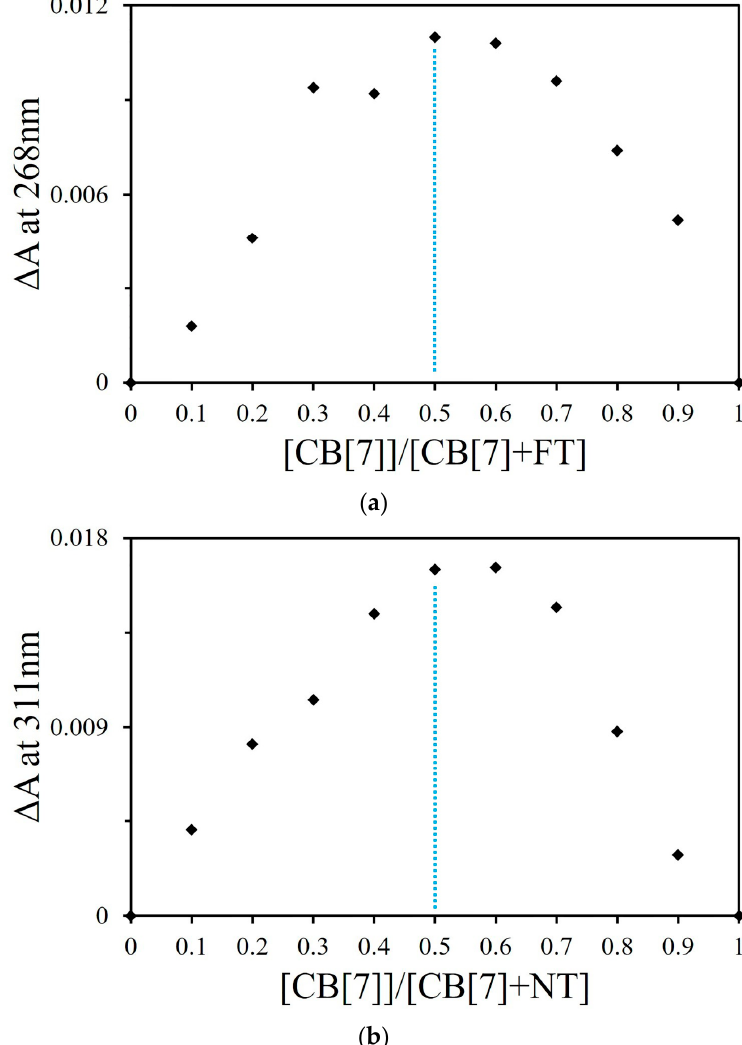
Figure 3. Job plots of FT@CB[7] complexes ( a ) and NT@CB[7] complexes ( b ).